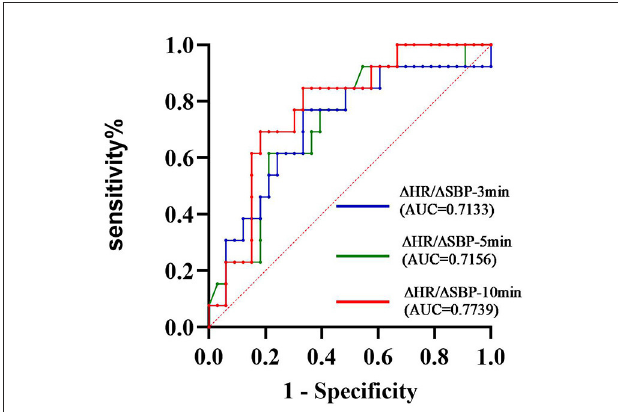
FIGURE3 ROC curve showing the sensitivity and specificity of the 1 HR/ 1 SBP ratio to distinguish between MSA and PD 1 HR/ 1 SBP-10min was considerably the best index (AUC =